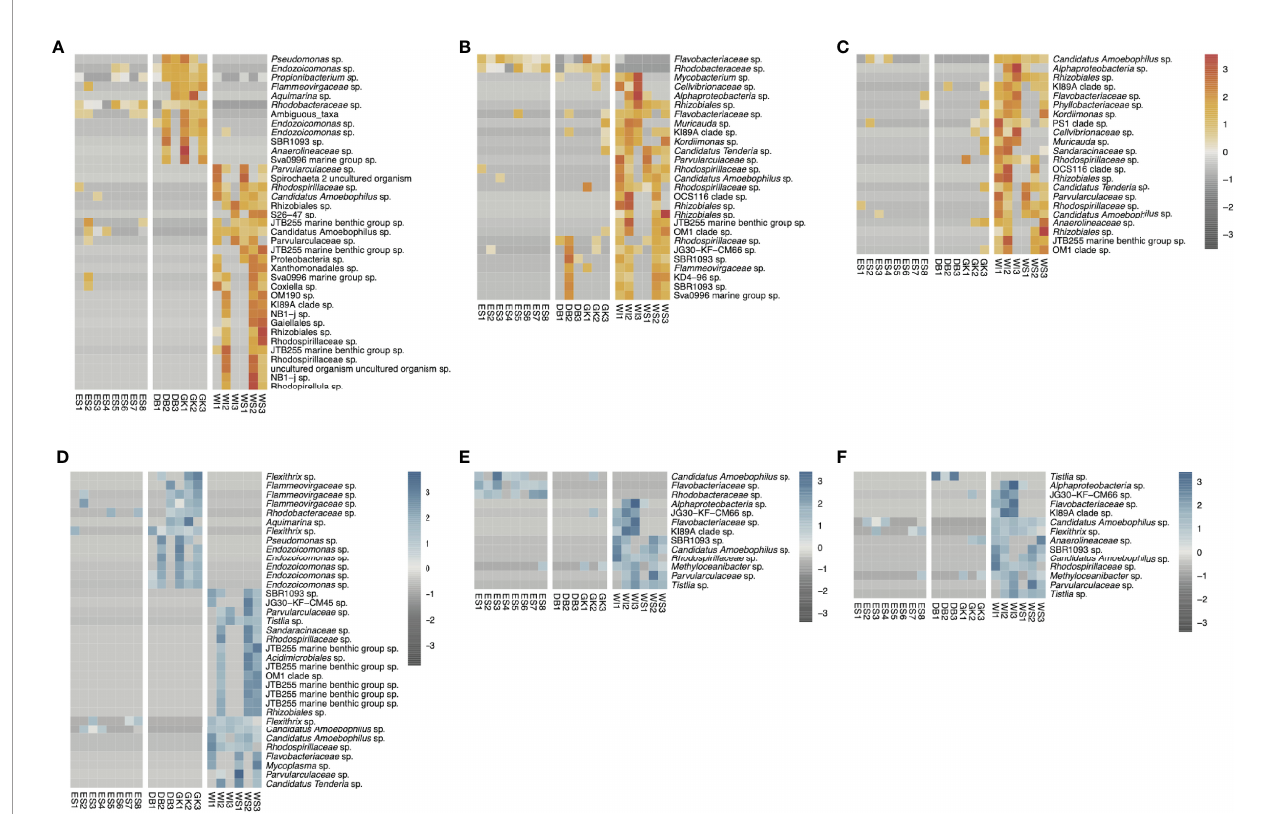
FIGURE 3 | Heatmaps of three FAs correlated with the top taxa at the three locations. (A) FA1 (Kuroshio Current and productivity factors)-correlated KTUs. (B) FA2 (inorganic salts factors)-correlated KTUs. (C) FA3 (minor local environmental factors)-correlated KTUs. The top 2.5% KTU high Spearman correlation coef fi cients, P < 0.01 were selected for visualizing. Heatmap of three FAs correlated with the top taxa in the three locations. (D) FA1 (Kuroshio Current and productivity factors)-correlated ASVs. (E) FA2 (inorganic salts factors)-correlated ASVs. (F) FA3 (minor local environmental factors)-correlated